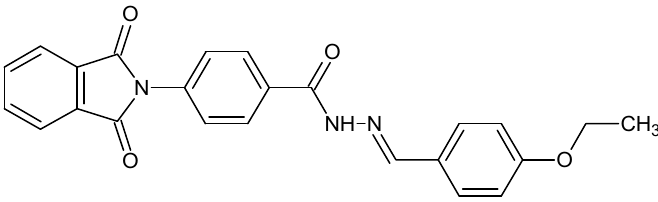
Figure 1. Chemical structure of the lipophilic thalidomide derivative (4-(1,3-dioxo-1,3-dihydro-2 H - isoindol-2-yl)- N ′ -[(4-ethoxyphenyl)methylidene]benzohydrazide ( 6P ).